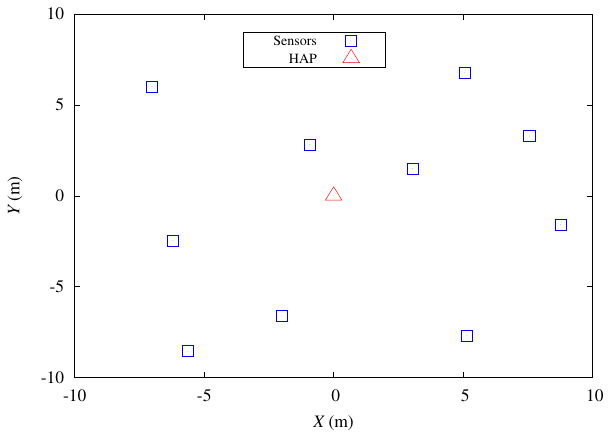
Figure 5. Deployment of HAP and wireless sensors in simulations. ( N =